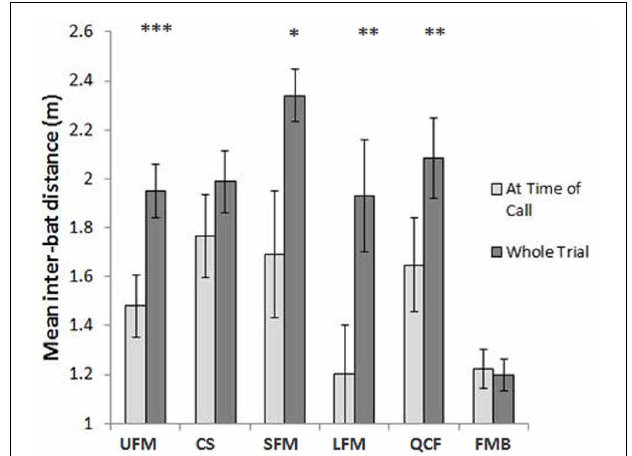
FIGURE 4 | Mean inter-bat distances before and after (“at time of call”) social calls were emitted and for trials containing these types of social calls overall. ∗ Indicates P < 0 . 05, ∗∗ indicates P < 0 . 01, and ∗∗∗ indicates P < 0 . 0001. Error bars represent one standard error. Call type abbreviations as in Figure 3 . The mean inter-bat distance for entire trials is smaller for trials containing FMB compared with other call types because almost all FMB were recorded from skilled trials, and skilled bats competing for prey tend to fly closer together and exhibit increased following/chasing behavior compared with naïve bats (Wright et al., 2011). The closer distances are not necessarily related to FMB